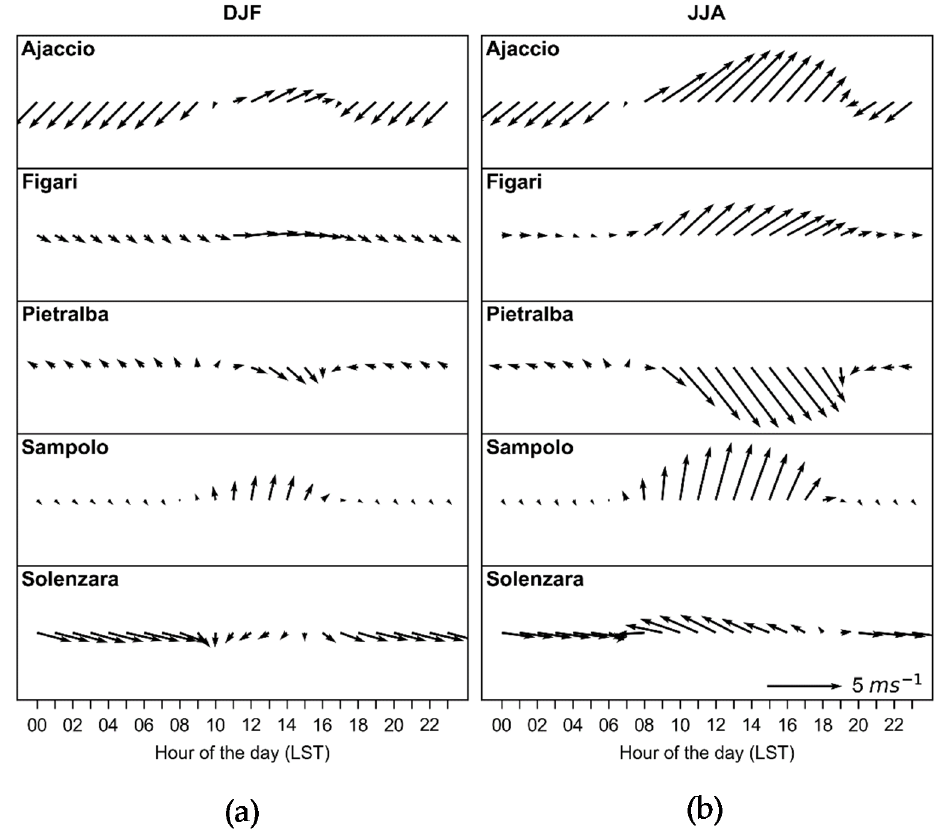
Figure 6. Mean wind direction and wind speed of the individual regions during the course of the day in ( a ) December to February (DJF) and ( b ) June to August (JJA); length of the arrows indicates wind speed.